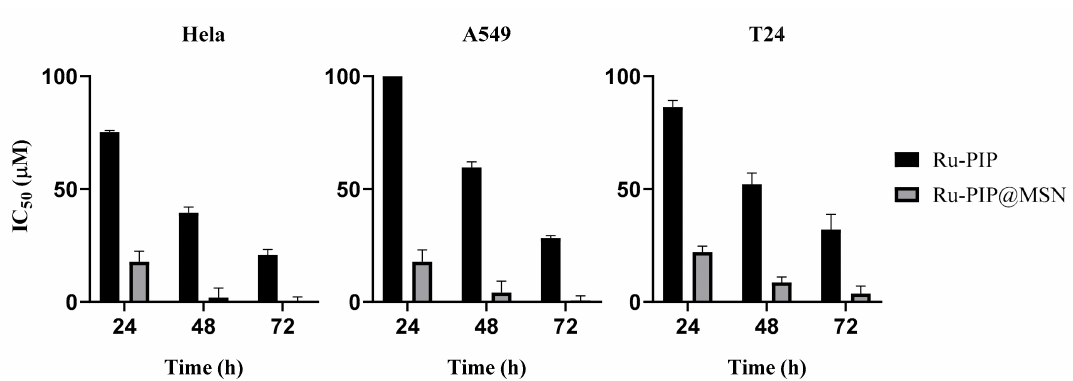
Figure 7. Graphical distribution of cytotoxicity (half-inhibitory IC 50 concentrations) of Ru-PIP and Ru-PIP@MSNs towards Hela, A549, and T24c cell